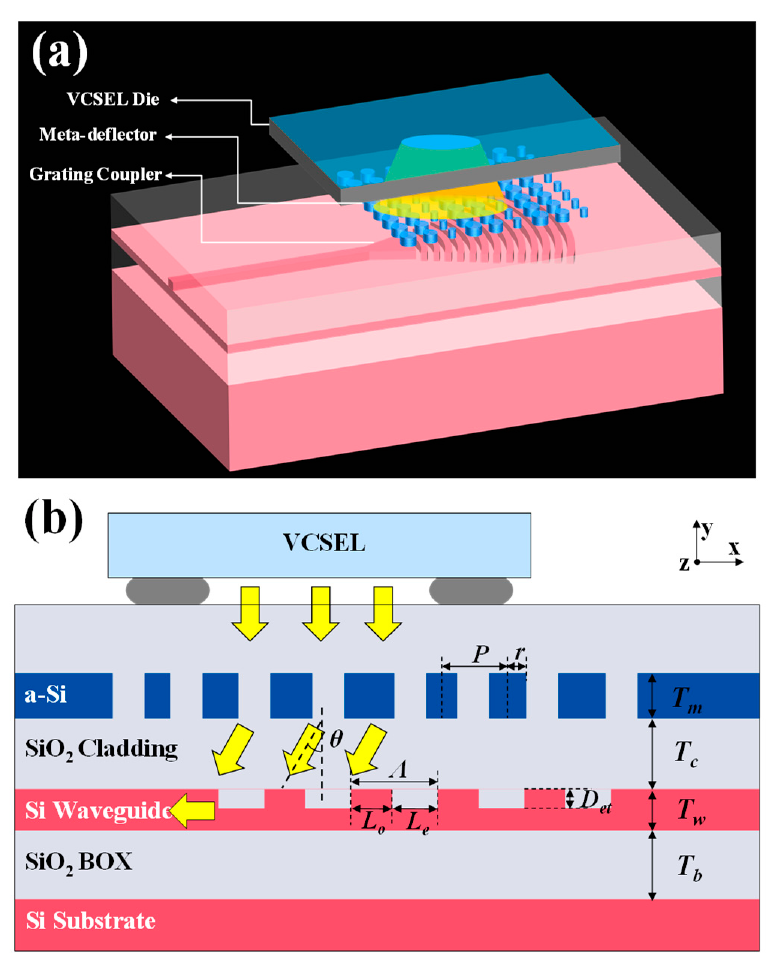
Figure 1. ( a ) Three-dimensional structure of proposed PVGC. ( b ) Cross-sectional schematic of proposed PVGC (the arrows mark the direction of light).